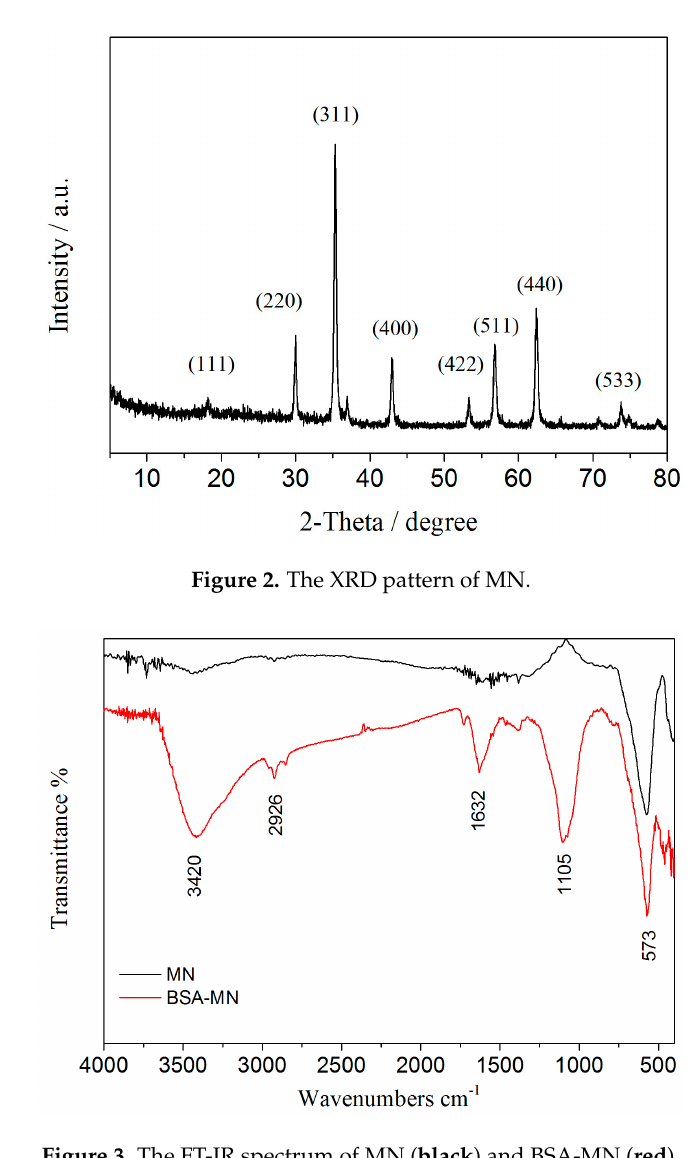
Figure 1. The TEM image of MN.